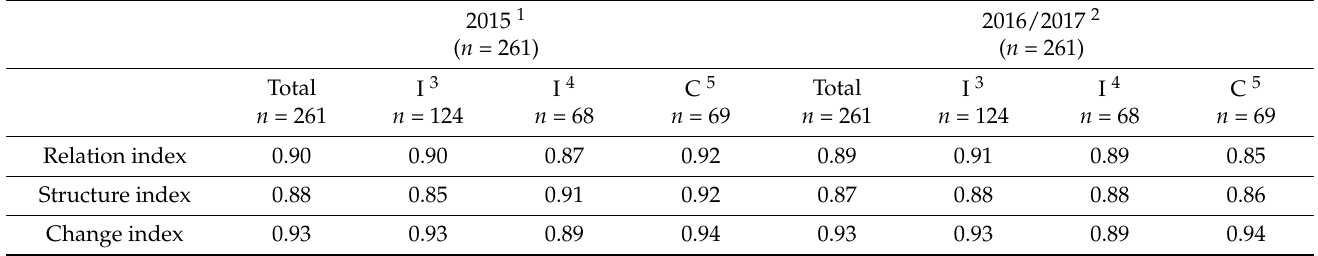
Table 2. Cronbach alpha for the relation-, structure-, and change-oriented indices for 2015 and 2016/2017 for the intervention and control